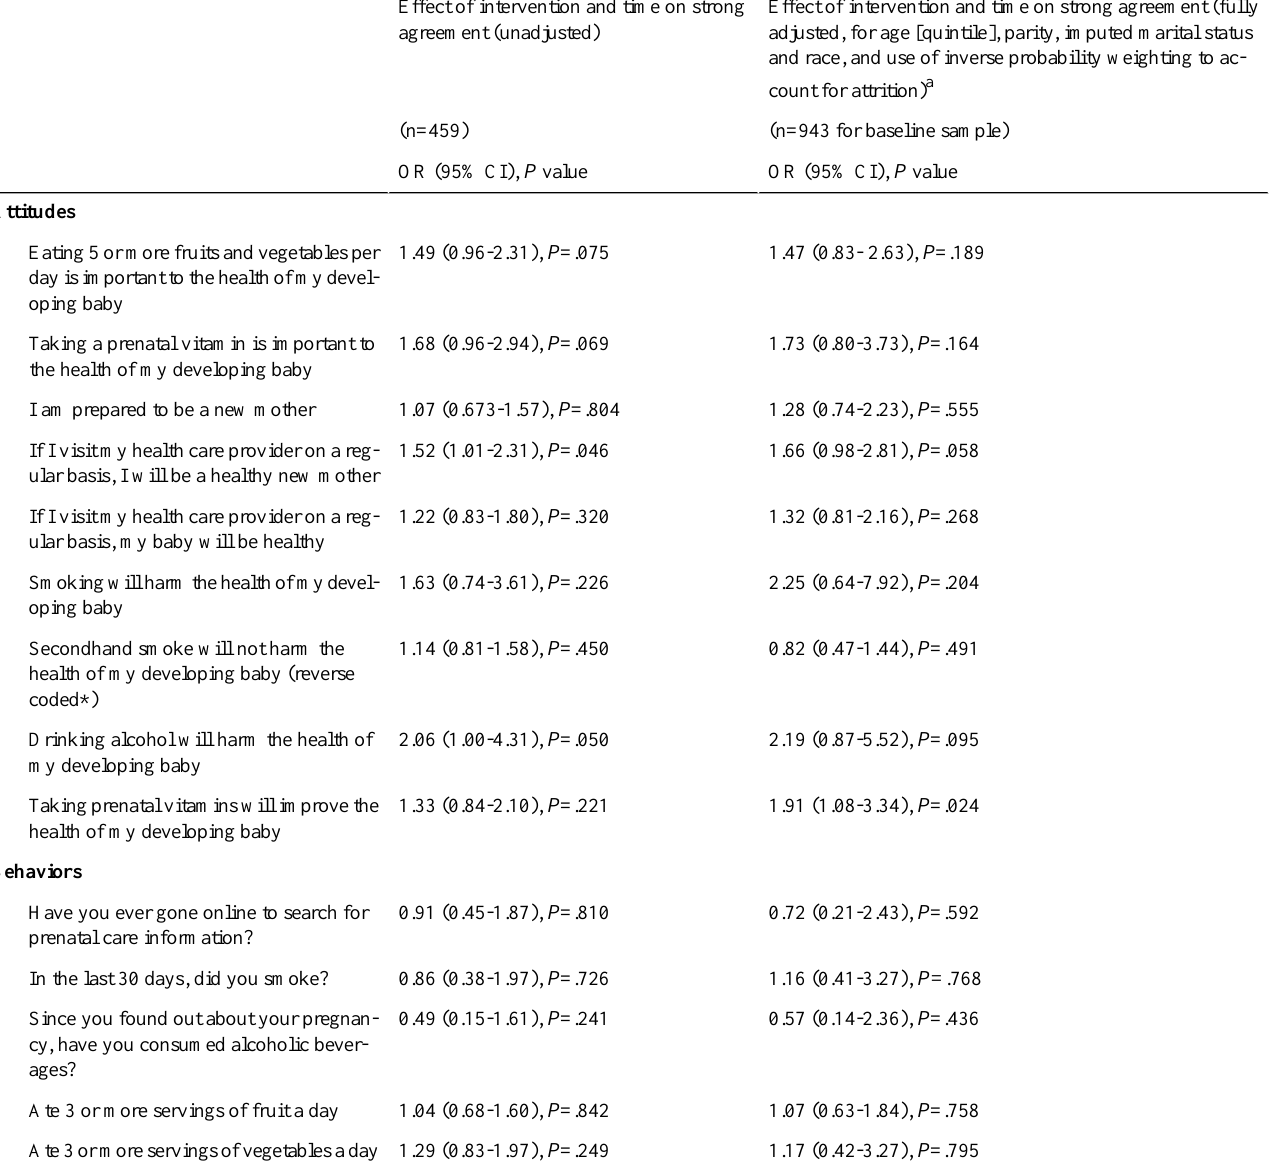
Table 3. Effects of Text4baby and covariates on improvements in outcome variables from baseline to follow-up. Effect of intervention and time on strong agreement (fully Effect of intervention and time on strong adjusted, for age [quintile], parity, imputed marital status agreement (unadjusted) and race, and use of inverse probability weighting to ac- count for attrition) a (n=943 for baseline